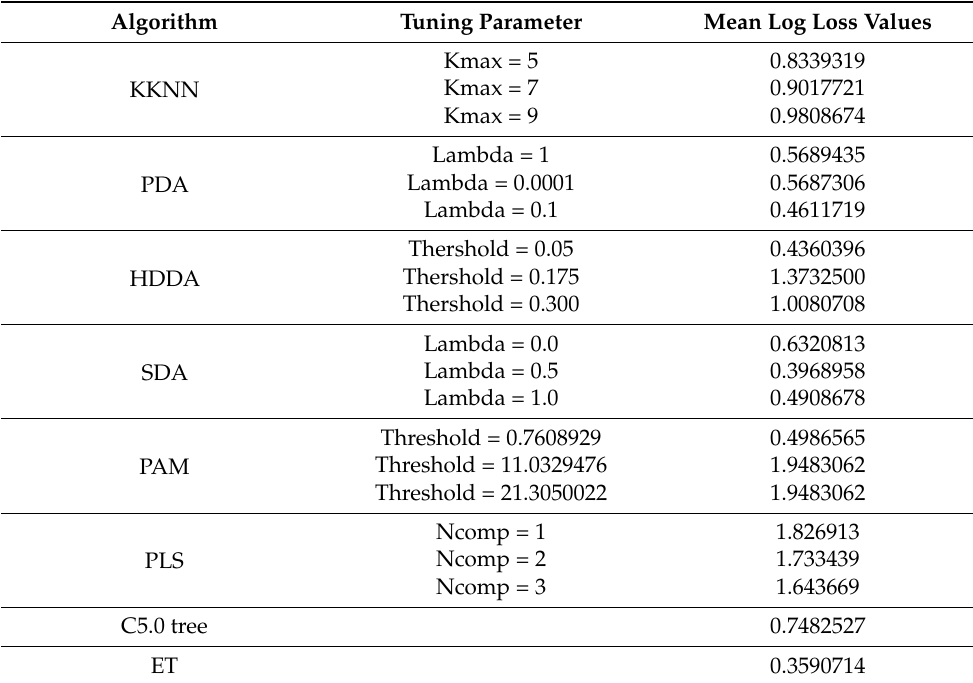
Table 1. Model optimization using the classifier algorithms. Log loss values are means of 10-fold cross-validation.